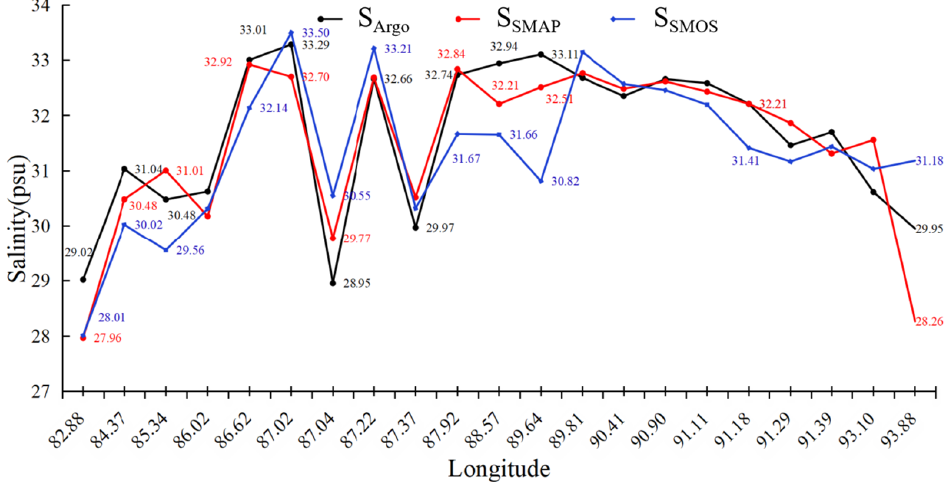
Figure 7. Distribution of sea surface salinity of SMAP and SMOS ( A , D ) ~8 days before and ( B , E ) ~8 days after TC Kyant (2016), and ( C , F ) salinity difference of SMAP and SMOS between ~8 days before and after TC Kyant.